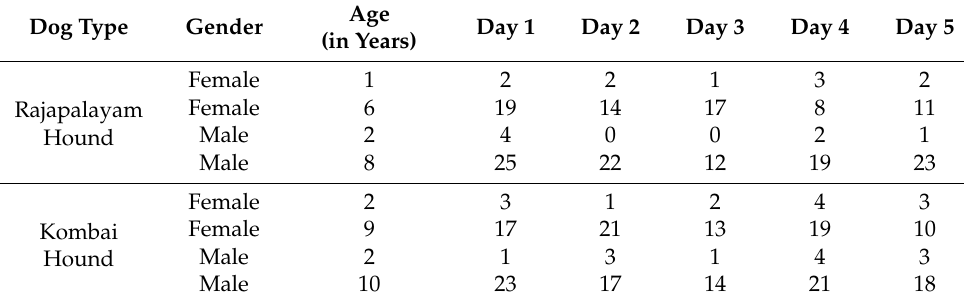
Table A2. Dog Sounds Recorded When the is Stranger